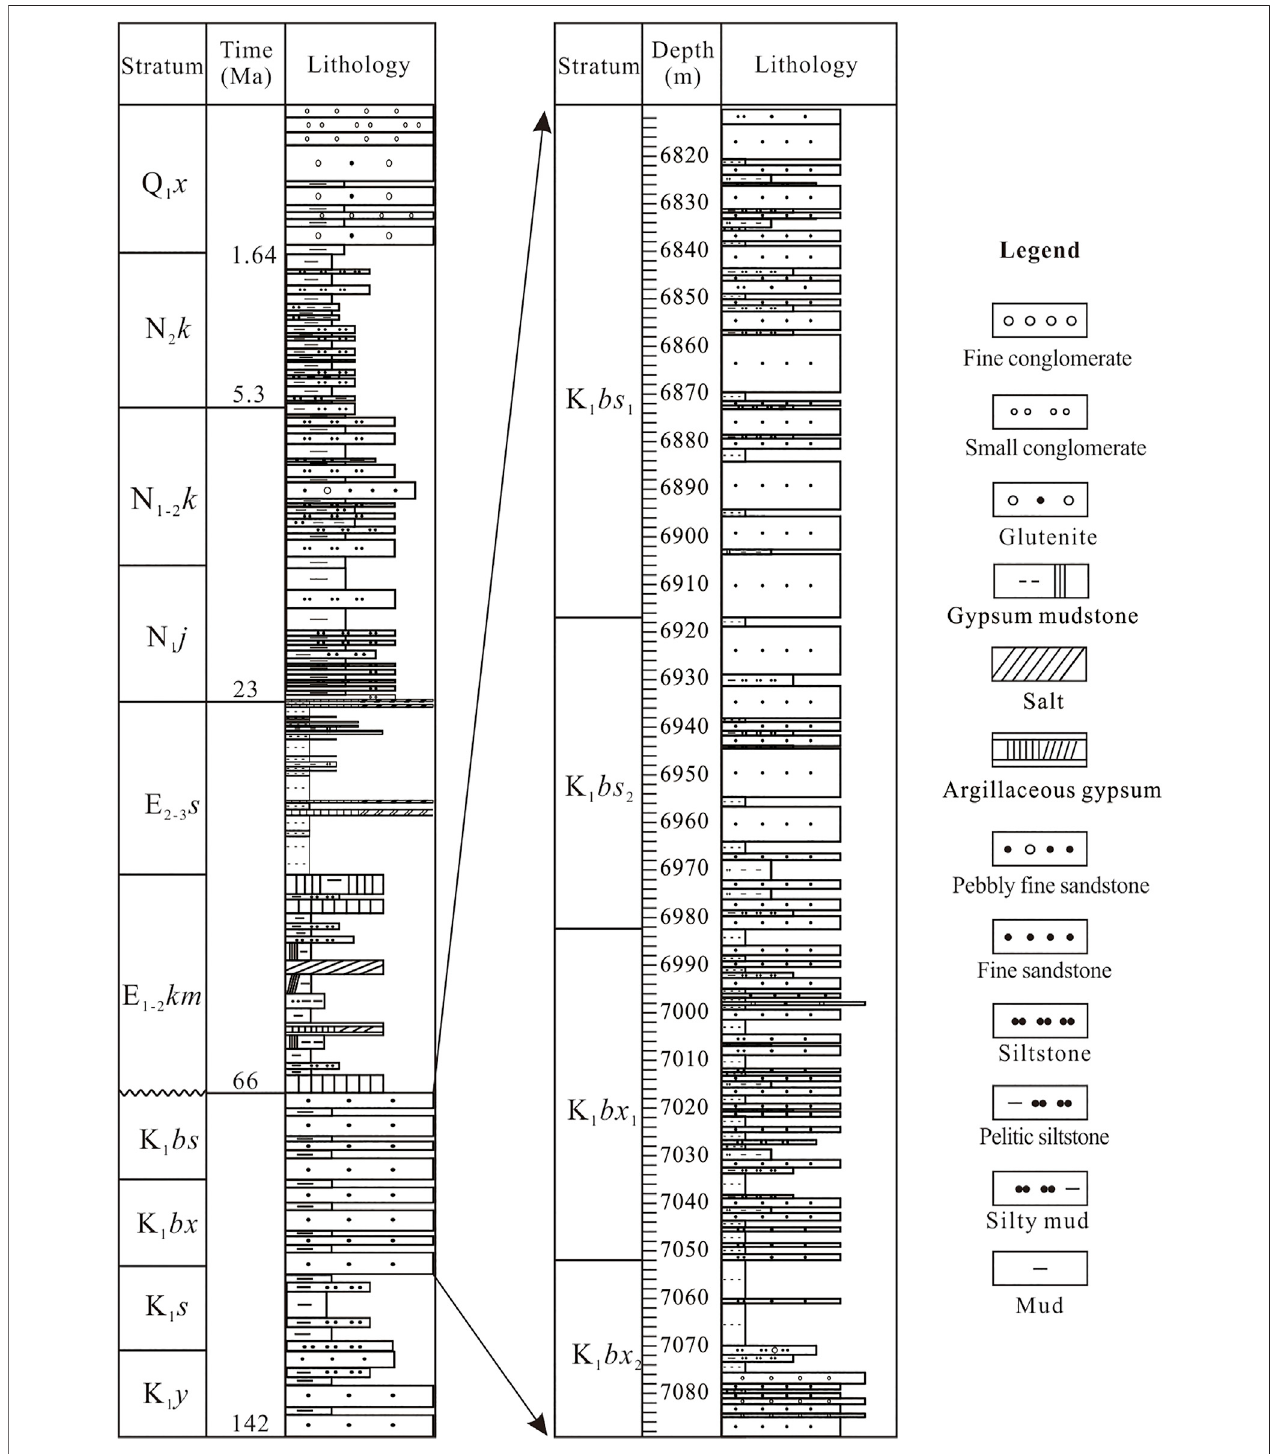
FIGURE 2 | From top to bottom, the strata encountered in the Bozi gas fi eld are: Quaternary Xiyu Formation (Q1 x ), Neogene Kuqa Formation (N2 k ), Kangcun Formation (N 1-2 k ), Jidike Formation (N 1 j ), Paleogene Suweiyi Formation (E 2-3 s ), Kumugelimu Group (E 1-2 km ), Cretaceous Bashijiqike Formation (K 1 bs ), and Baxigai Formation(K 1 bx ).TheBashijiqikeFormationisdividedintothesecondlithologicsection(K 1 bs 2 )andthethirdlithologicsection(K 1 bs 3 )fromtoptobottom,withoutthe fi rst lithologic section. The Baxigai formation is divided into the fi rst lithologic section (K 1 bx 1 ) and the second lithologic section (K 1 bx 2 ) from top to bottom.